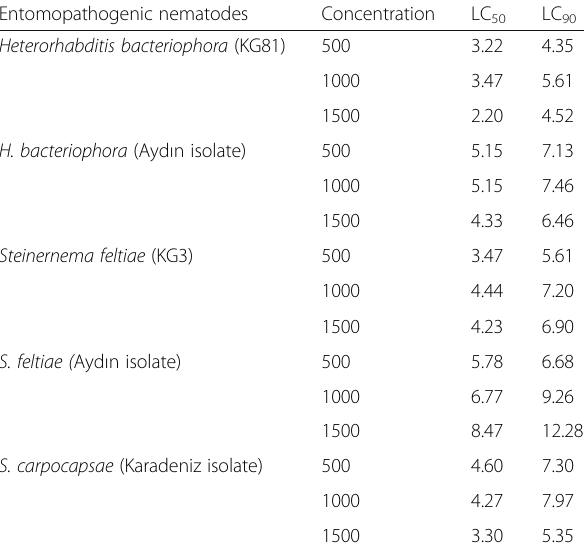
Table 2 LC 50 and LC 90 for Culex pipiens treated with entomopathogenic nematode